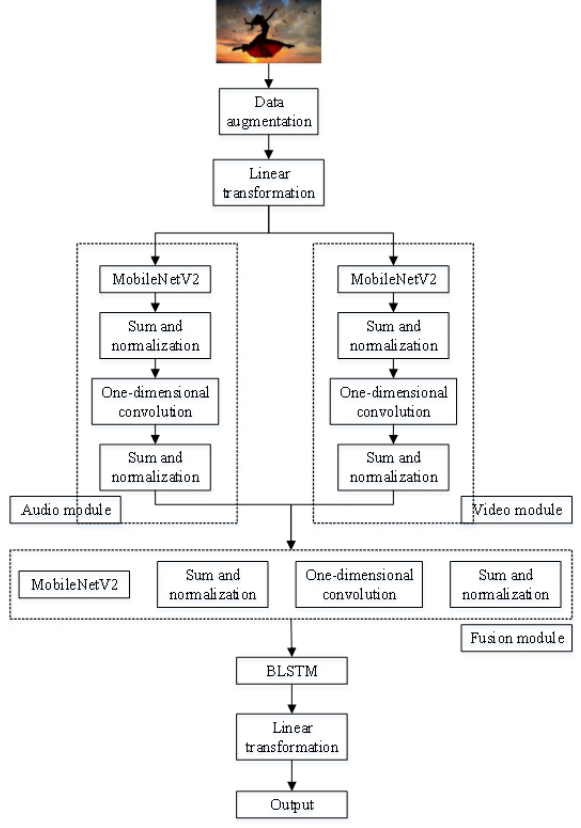
Fig. 2. Framework of proposed dance emotion